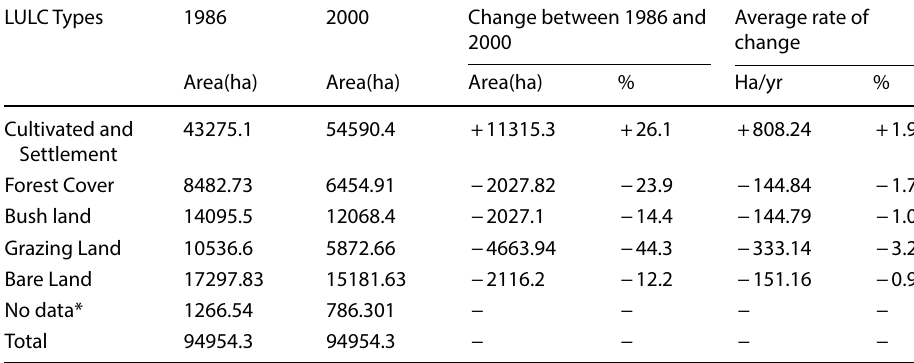
*Clouds and shadows